Question: Is the quantity shown trending increasing or decreasing?
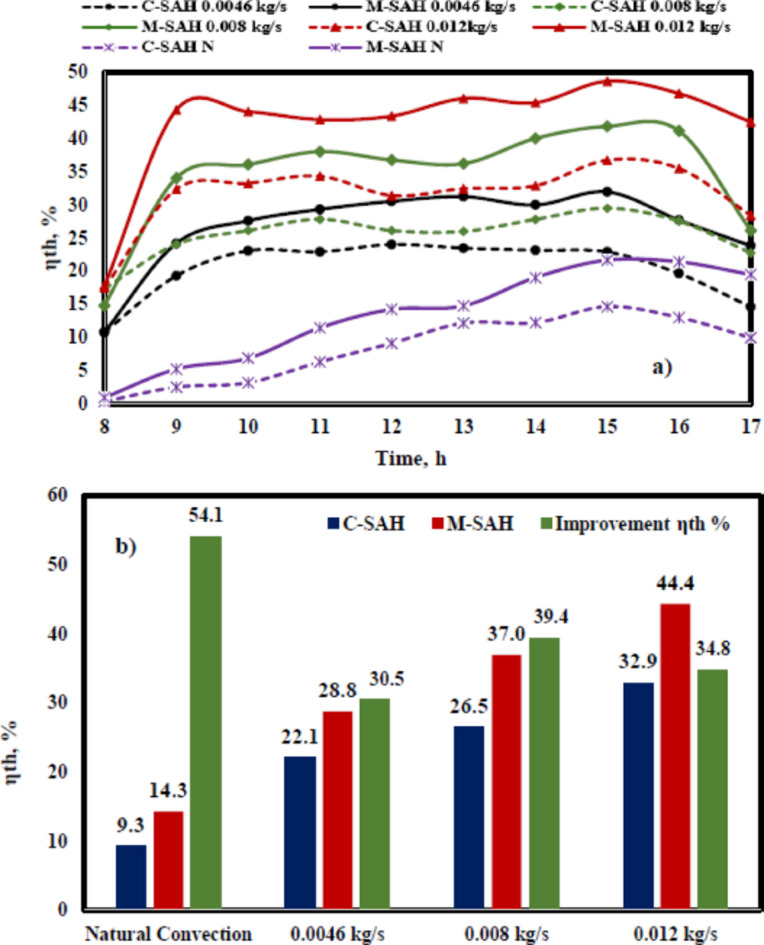
Answer: increasing